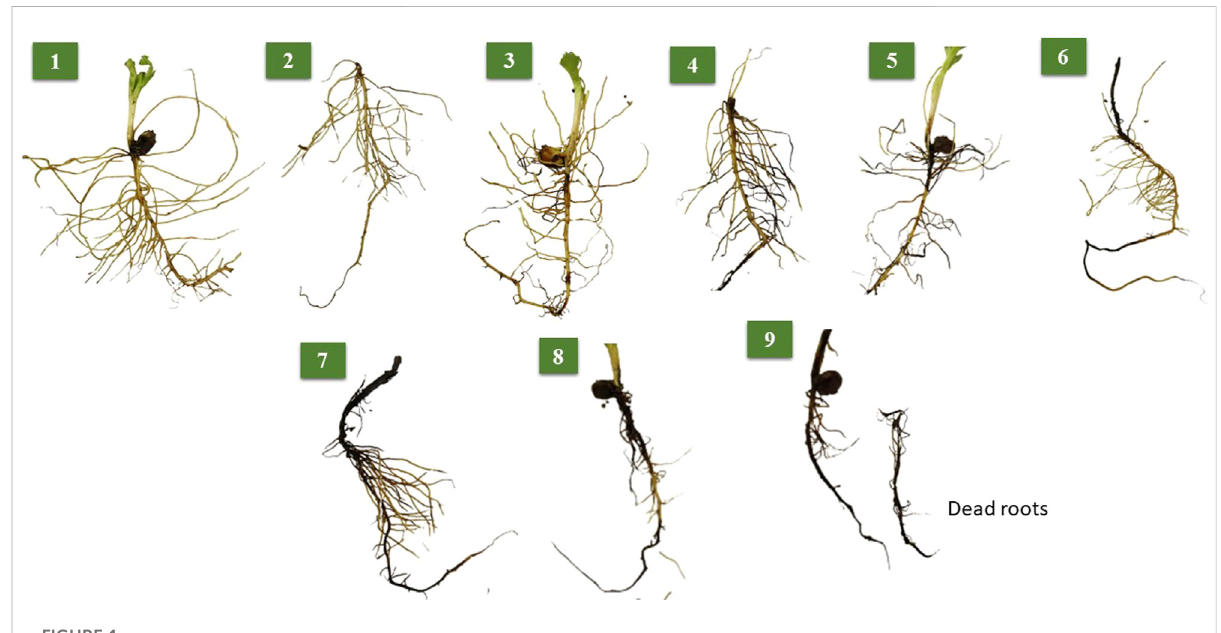
FIGURE 1 Visual scoring of root frost susceptibly scored on the 189